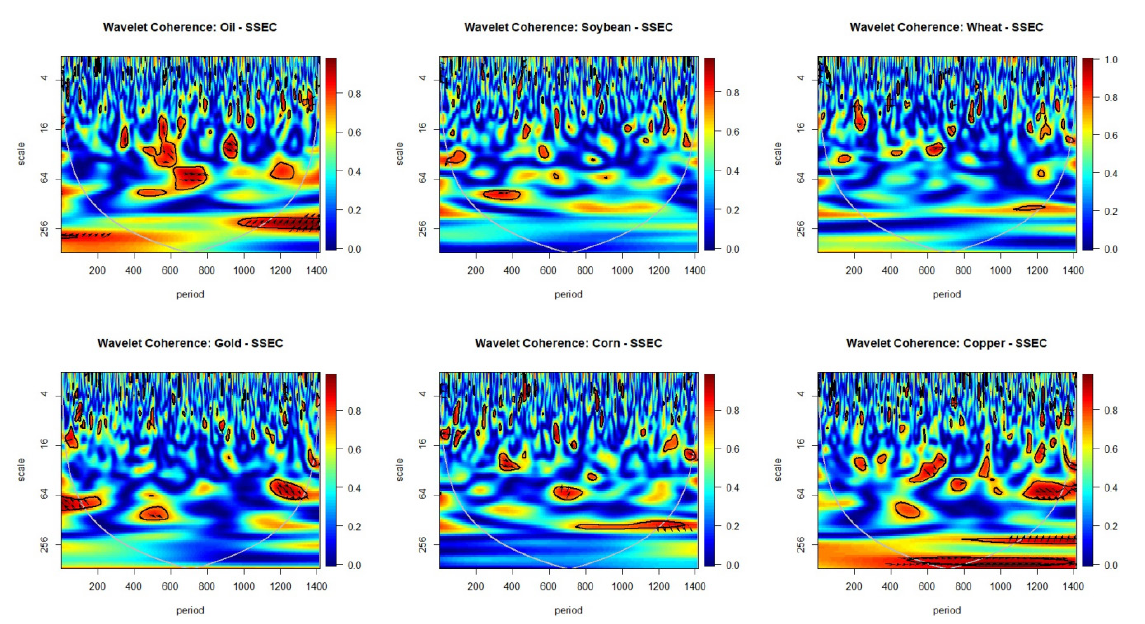
Figure 5. The wavelet coherency between major commodity and Chinese stock